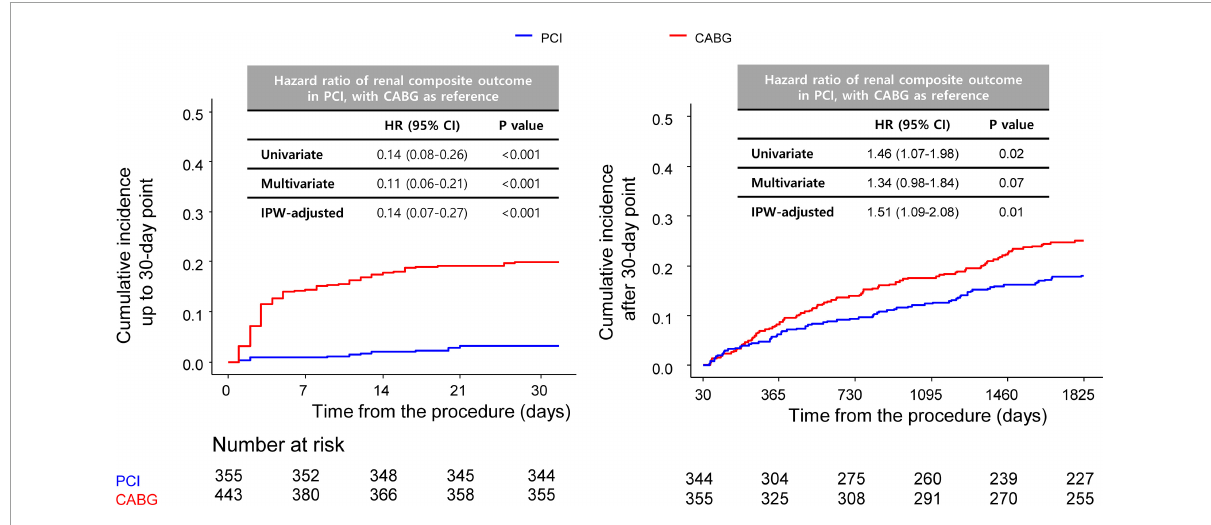
FIGURE3 Comparison of 5-year renal outcomes between CABG and PCI. Kaplan–Meier curve comparing 5-year renal composite outcomes between the PCI and CABG groups with landmark analysis before (left) and after (right) 30 days. CABG, coronary artery bypass graft; PCI, percutaneous coronary intervention.